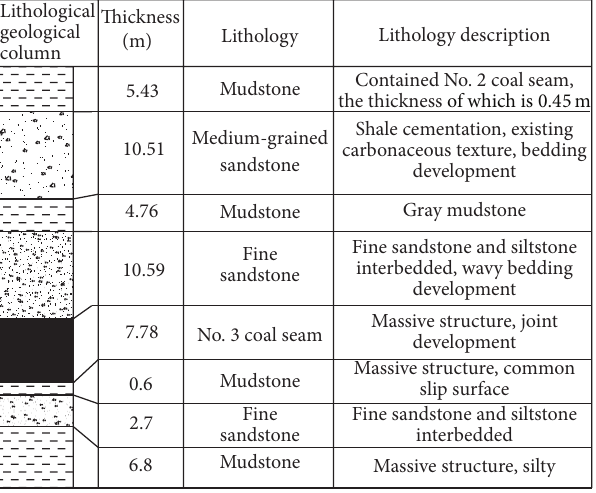
Figure 1: Strata histogram of 3# coal seam roof and